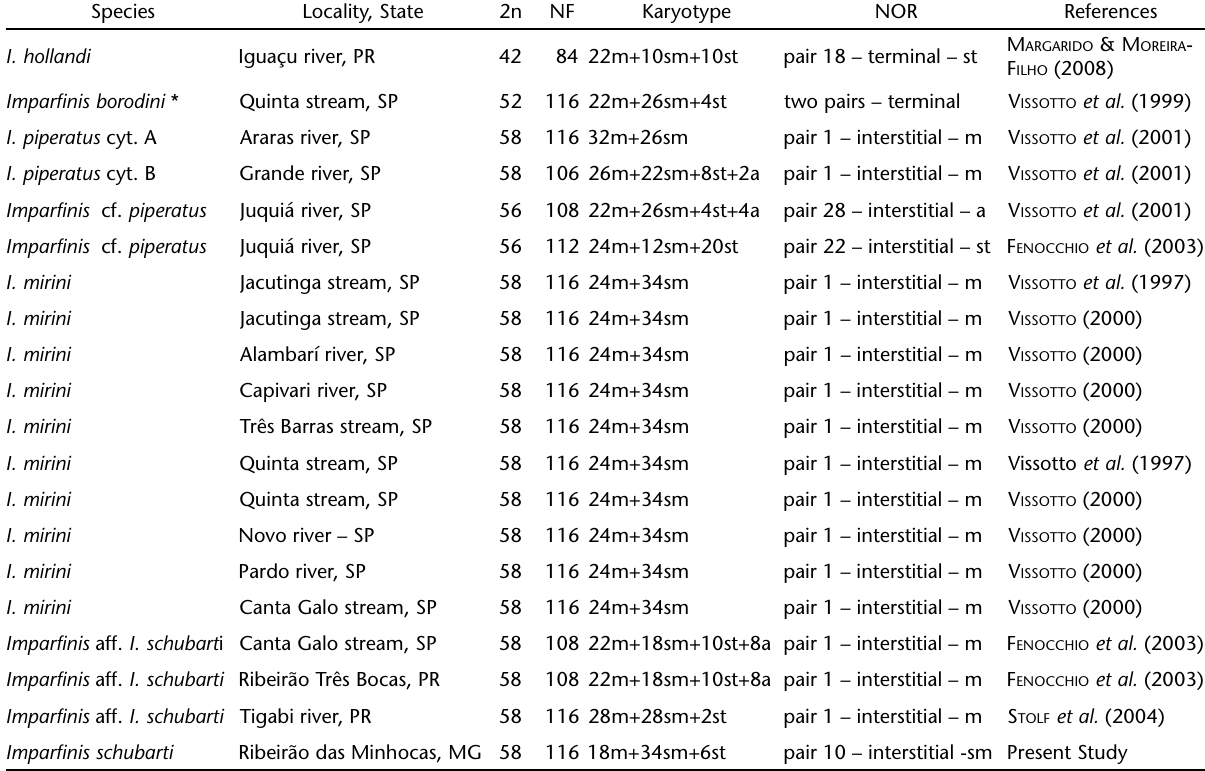
Table I. Cytogenetic data avaliable for Imparfinis